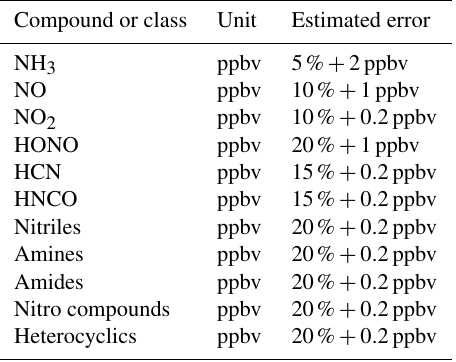
Table 2. Compounds and compound classes used in the PMF anal- yses and their corresponding